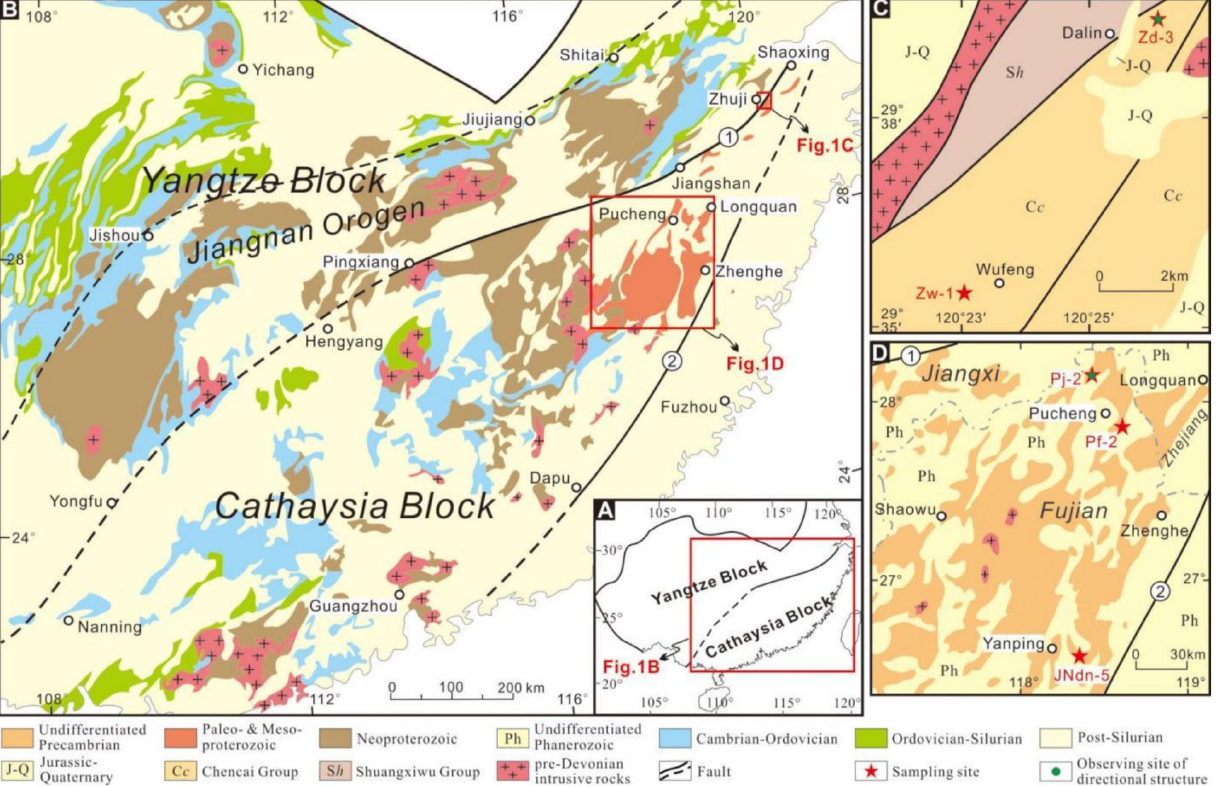
Figure 1. ( A ) South China Craton composed of the Yangtze and Cathaysia blocks; ( B ) geologi- cal sketch maps of eastern South China; ( C ) detailed geological map of the southern Zhuji area; and ( D ) the central Wuyi mountains ( D ).